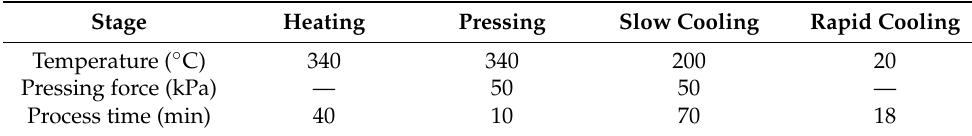
Table 2. The molding conditions and process parameters used in this